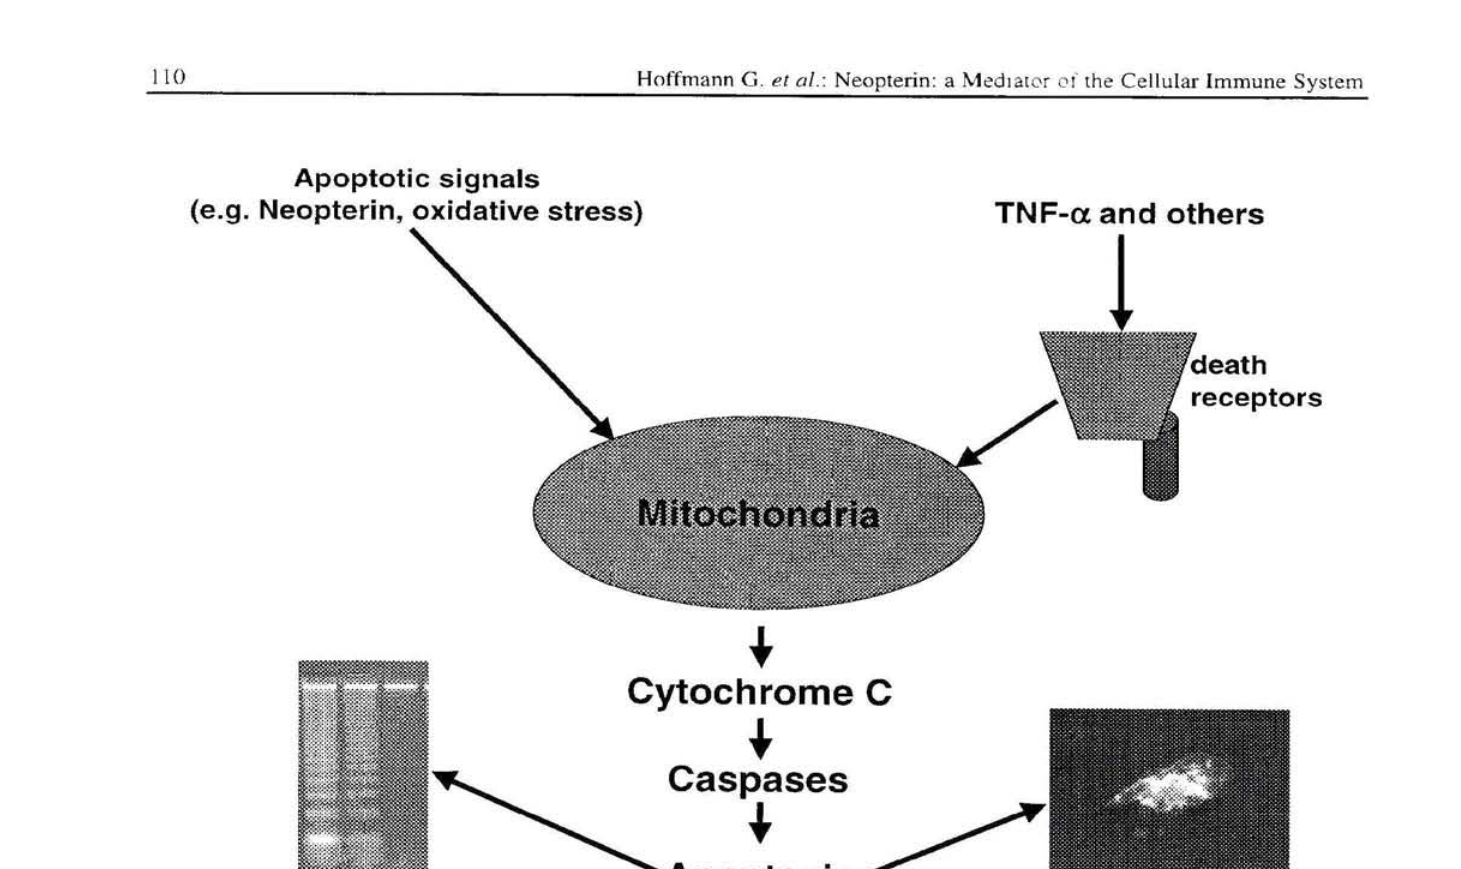
Figure 4. Potential role of neopterin in the activation of programmed cell death (apoptosis). Pro-apoptotic sig- nals trigger the release of cytochrome C from mitochondria. Subsequently, a cascade of enzymes (caspases) is activated which finally leads to the characteristic events of apoptosis, e.g. DNA fragmentation (which can be visualized via agarose gel electrophoresis of isolated cellular DNA, left insert) or blebbing of cells (which can be visualized via fluorescence microscopy, right insert). Most likely, neopterin acts via oxidative stress pathways to initiate apotosis, while cytokines like tumor necrosis factor-α (TNF-a) require specific cell death receptors